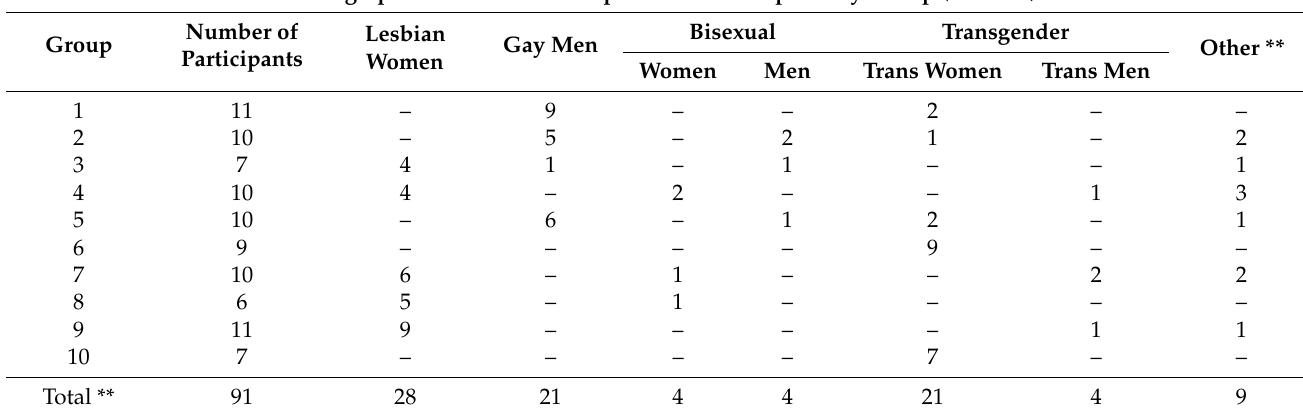
Table 1. Demographic Characteristics by Focus